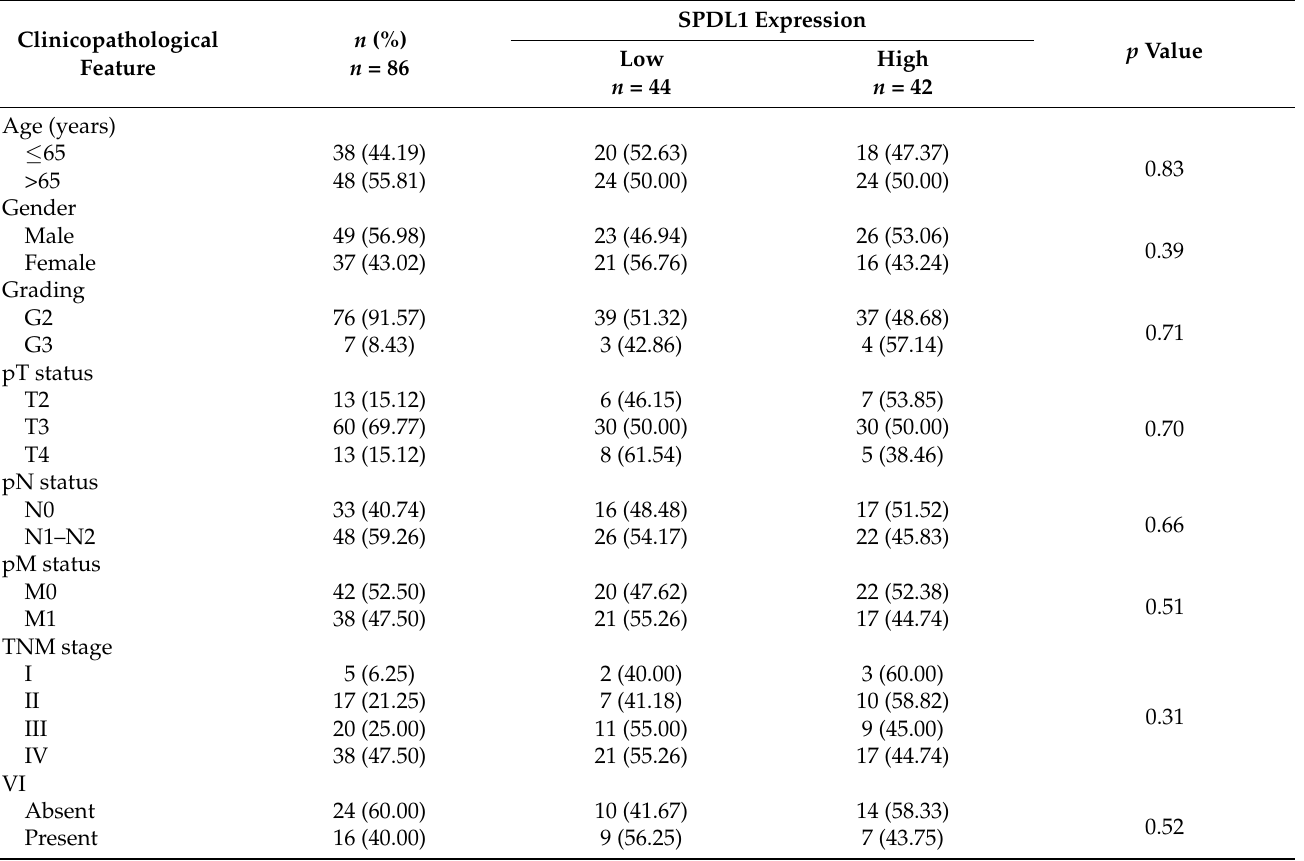
Figure 1. ( A ) Immunohistochemical expression of SPDL1 in colorectal cancer compared to non ‐ cancerous adjacent tissues. The error bars present the range from minimum to maximum values of data. Asterisk (*) indicates statistically significant difference ( p < 0.05). ( B ) The optimal cut ‐ off value established for SPDL1 based on IRS scores and Evaluate Cutpoints software. Table 1. Association of SPDL1 protein expression with clinicopathological parameters of colorectal cancer patients.